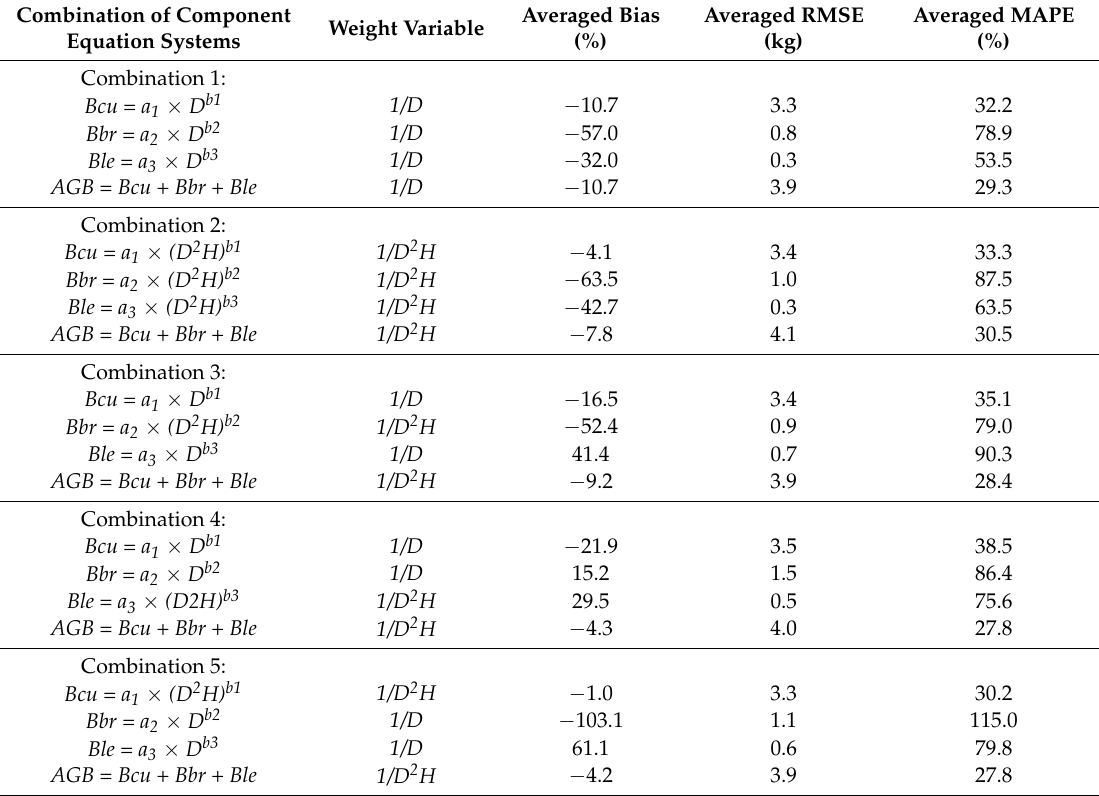
Table 3. Using SUR method to develop and validate simultaneously model combinations with 200 realizations; 70% randomly split dataset for developing simultaneous models; and 30% randomly split dataset for validation, calculation of averaged bias, RMSE, and